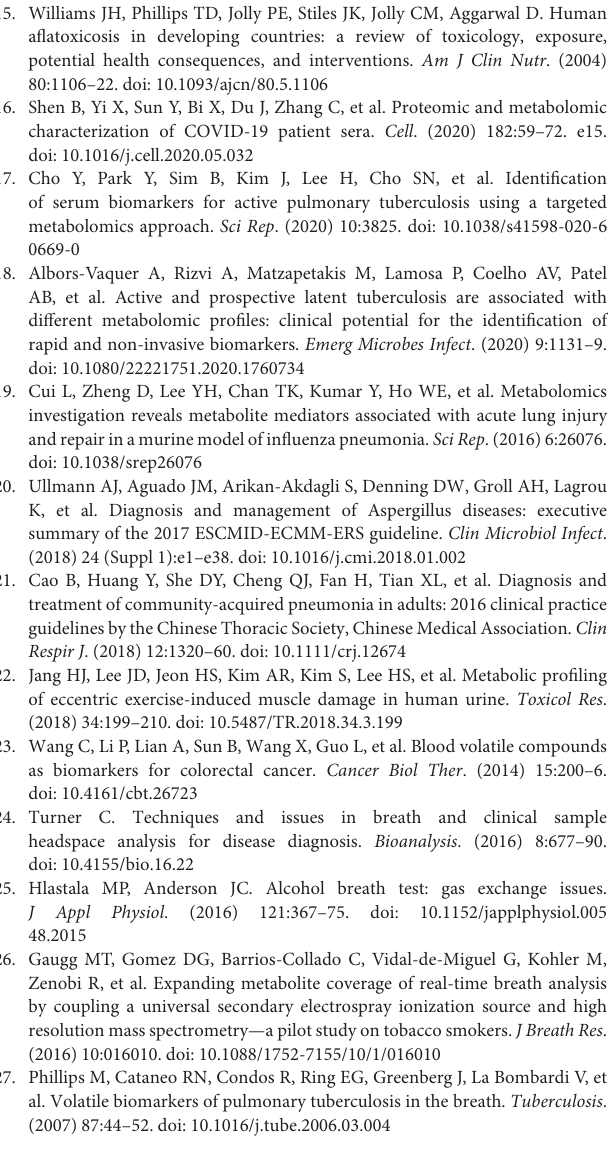
Supplementary Figure 1 | Flow chart of the enrolled participants. Supplementary Table 1 | Clinical characteristics of patients in case group and control